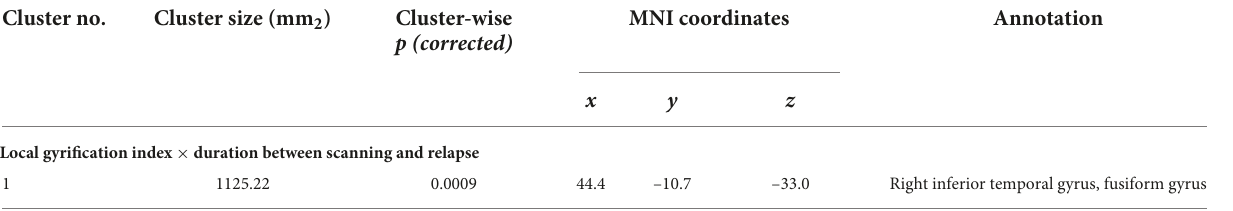
TABLE 3 Clusters with significant correlation of local gyrification index with clinical